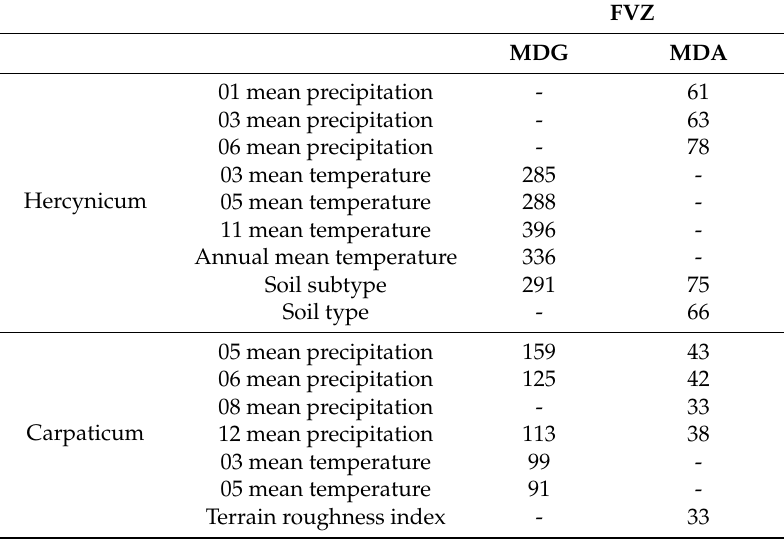
Table 3. The best RF predictors of FVZ based on both MDG and MDA for Hercynicum and